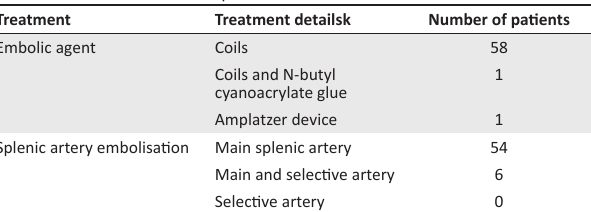
TABLE 2: Embolisation